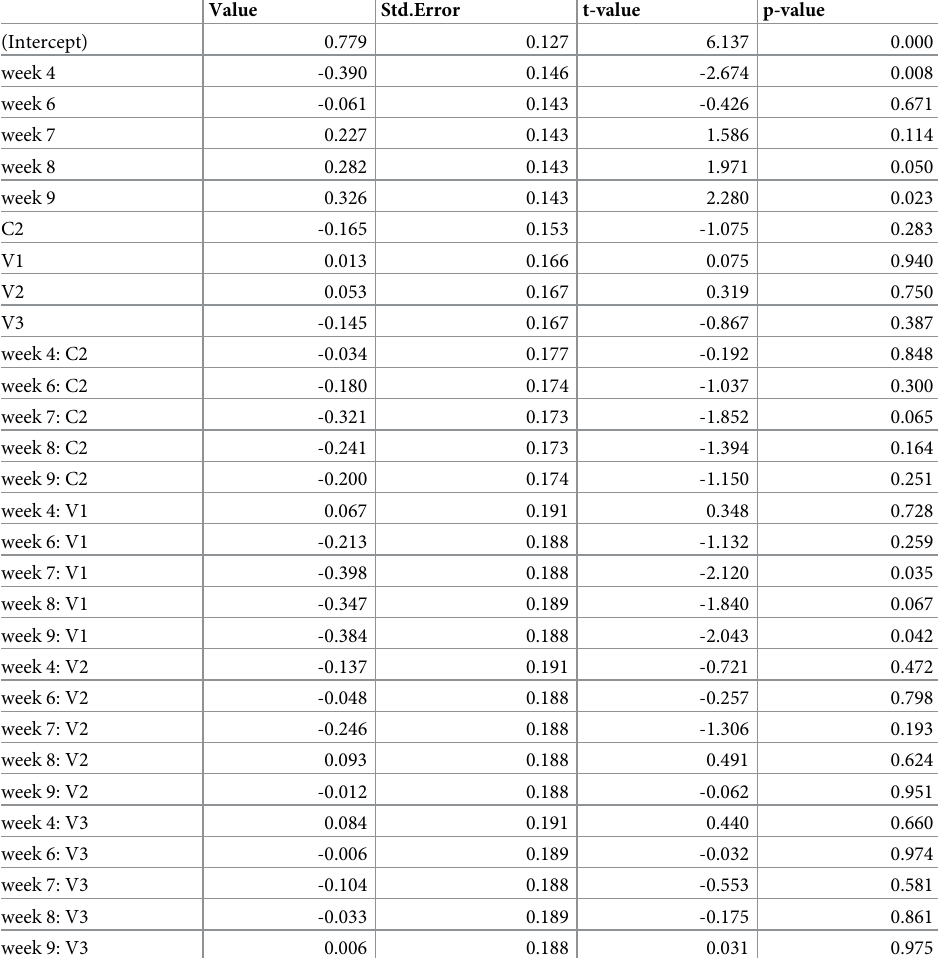
Table 2. Coefficients of the generalized least square analyses of pha-index dependent on group and age in weeks. The table shows the estimated value, the standard error, the t-value and the significance (p-value) of the terms. The rows represent the groups, the age in weeks and their interactions. Values indicate the differences to the reference value (intercept), which represents pha-index from the control group C1 at the age of two